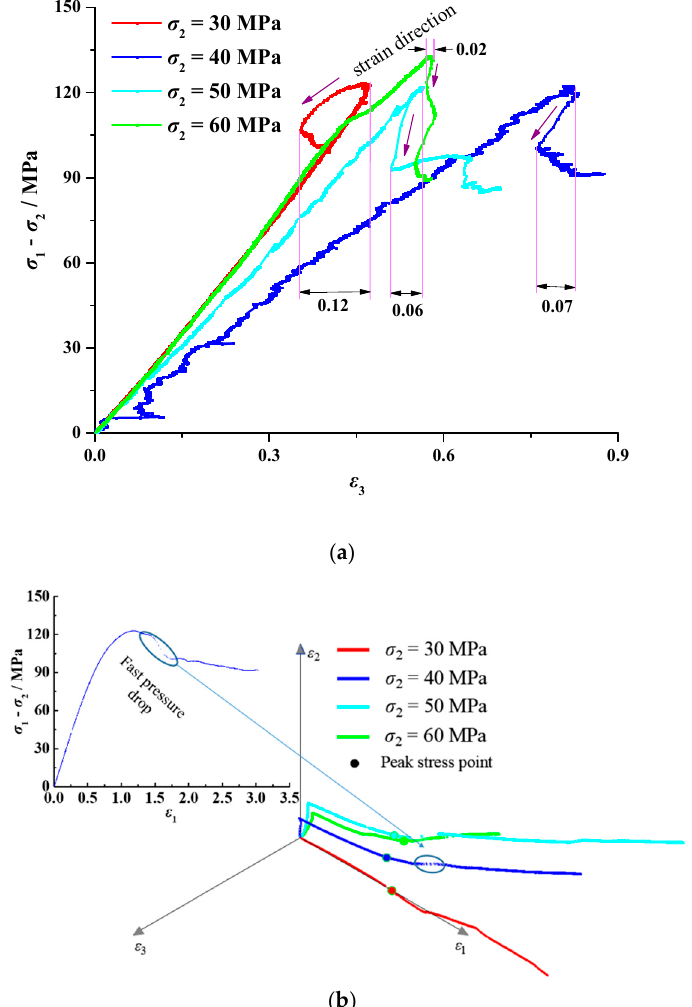
Figure 9. Rock deformation characteristics under different stress states. ( a ) Variation in the volume strain under different σ 2 values when σ 3 = 30 MPa; ( b ) deviator strain under different σ 2 values when σ 3 = 30 MPa.